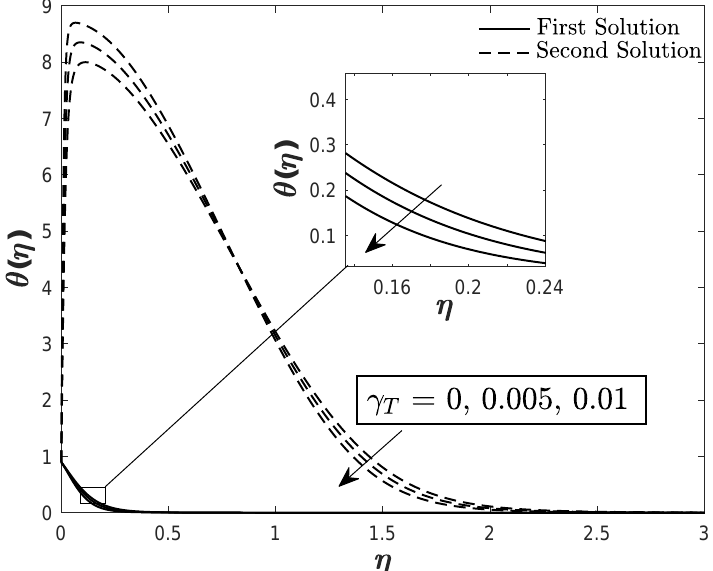
Figure 8. Effect of thermal relaxation γ T on the temperature profile.